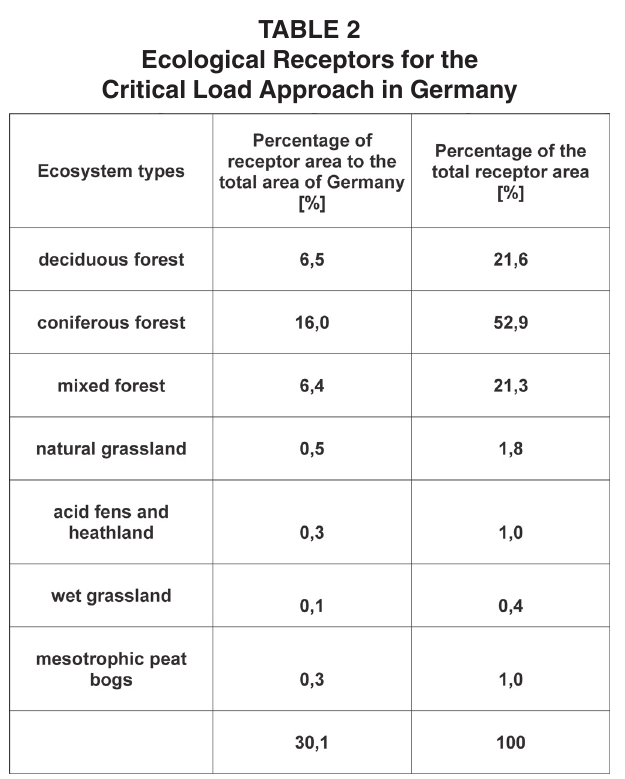
Ecological Receptors for the